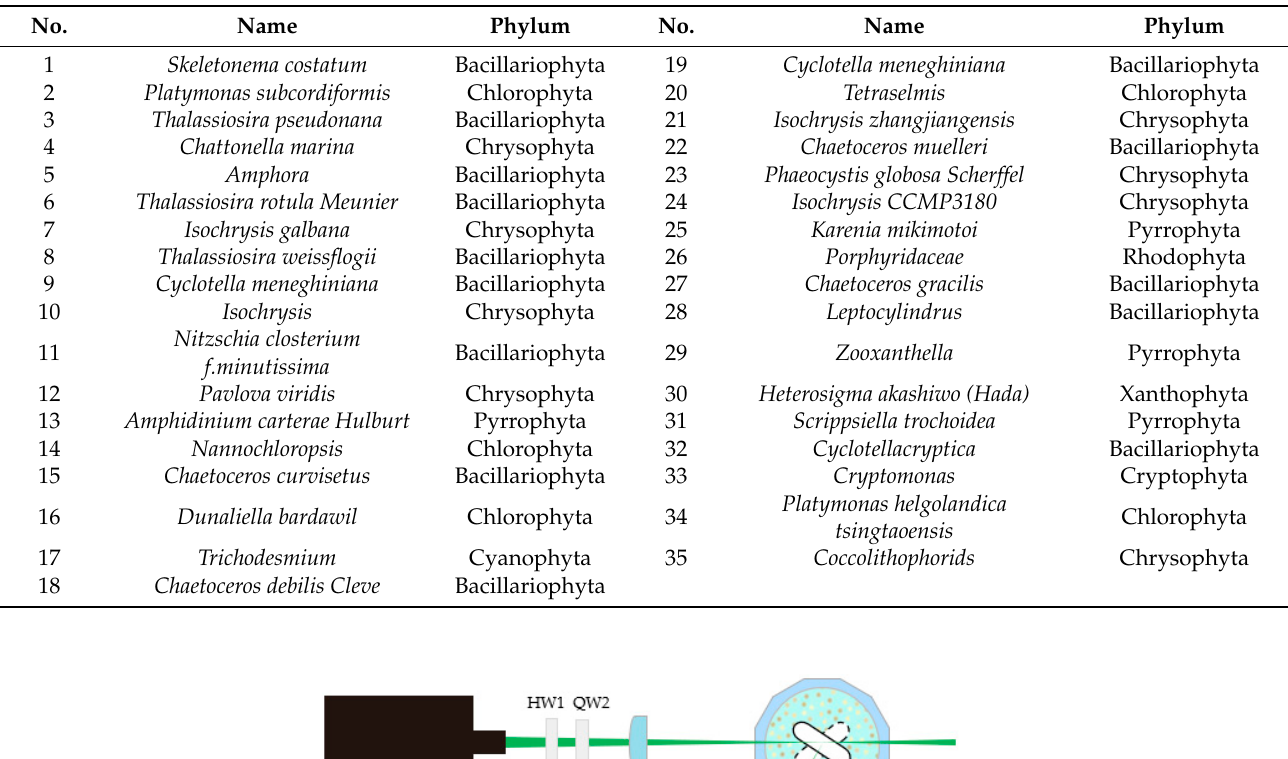
Table 1. Detailed information of samples used in this work.